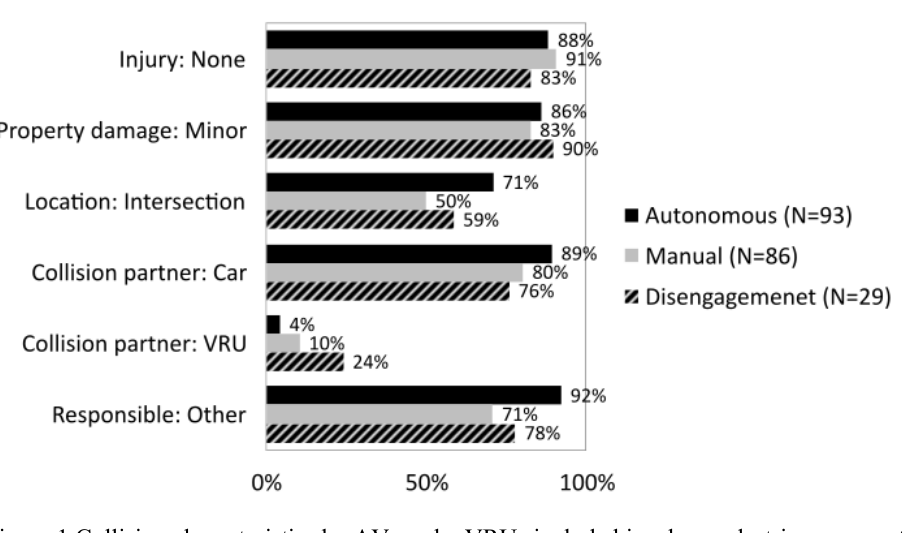
Figure 1 Collision characteristics by AV mode: VRUs include bicycles, pedestrians, e-scooters, and motorcycles; cars include passenger cars, vans, SUVs and pick-ups